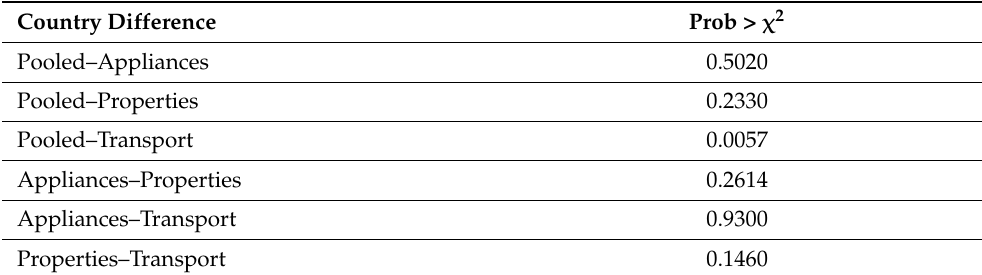
Table 15. Wald test results for the pooled and technological subsample models